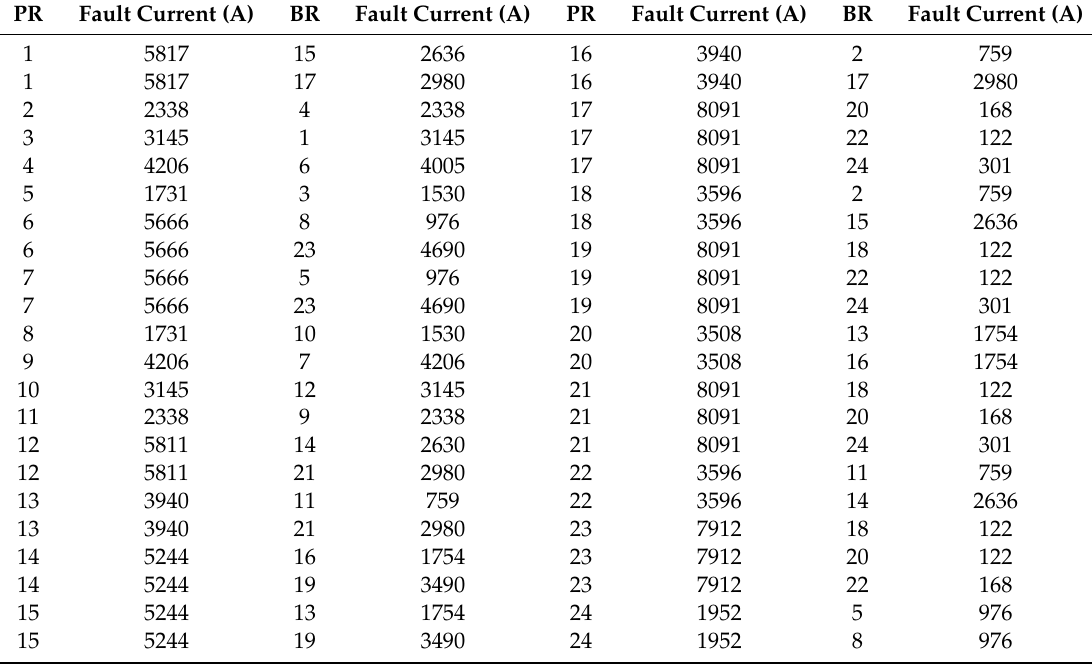
Figure 4. Diagram of a four SPVG-connected 9-bus system. Table 6. Fault current for P/B DOCR pairs of 9-bus system.